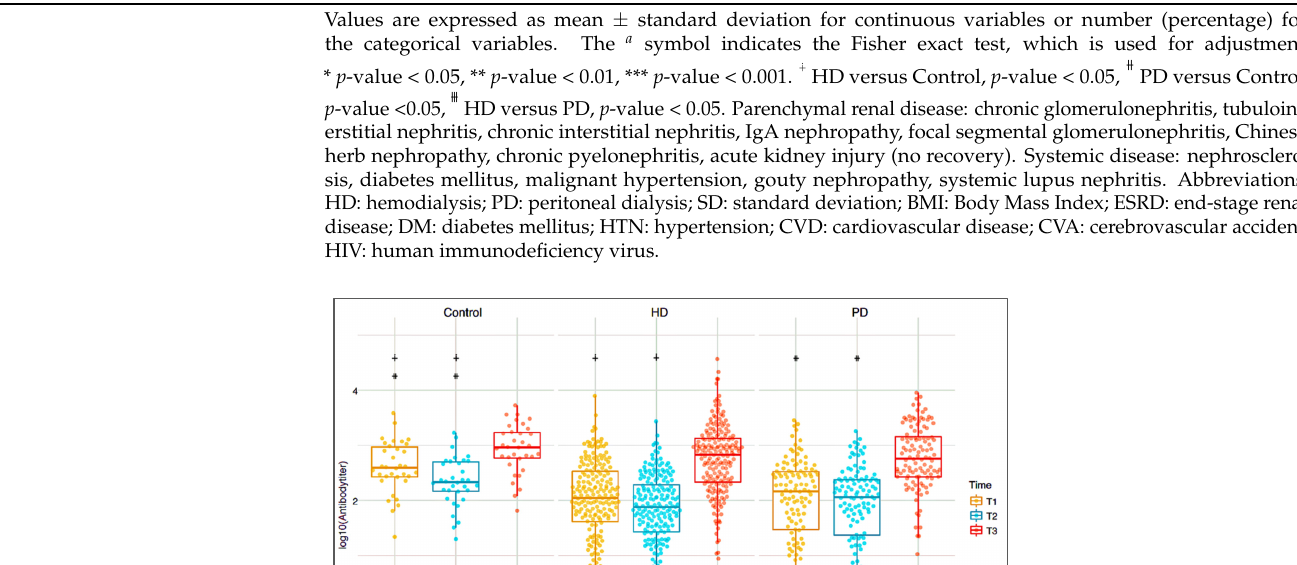
Table 1. Baseline demographic data and characteristics of the subjects in the study.